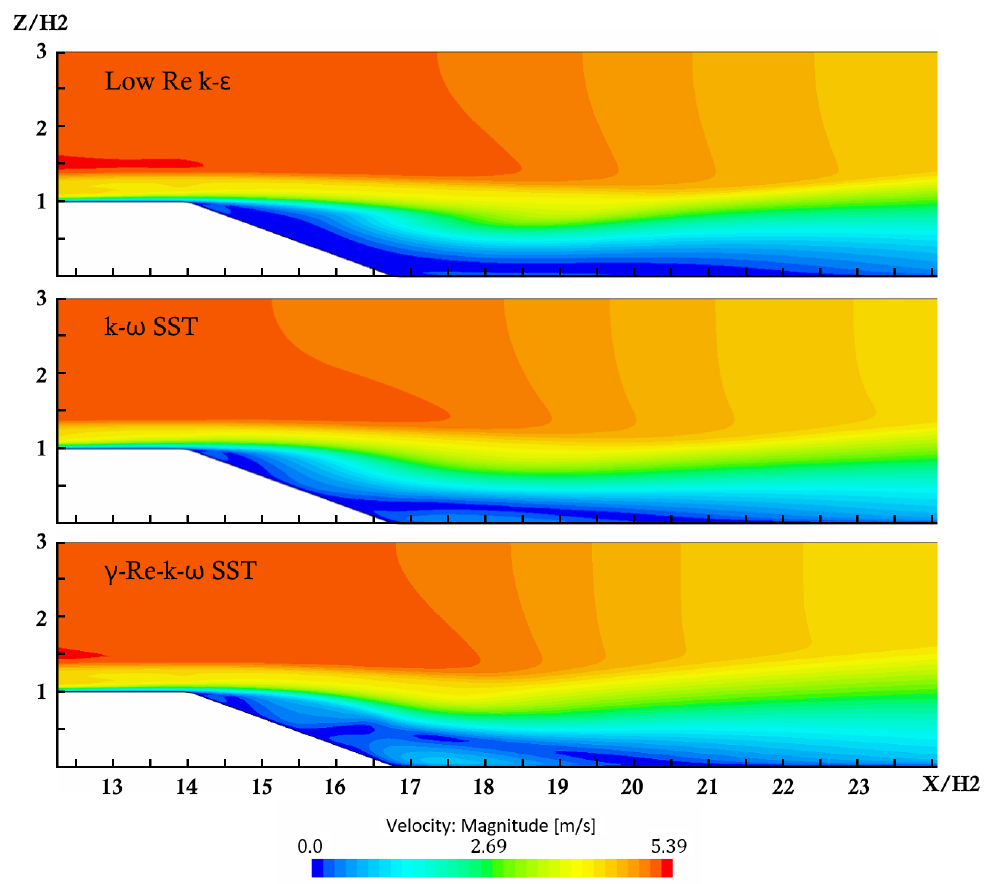
Figure 11. Simulated velocity magnitude profiles around the backward-facing ramp for the type A knitted wire mesh with two rows using different turbulence models.